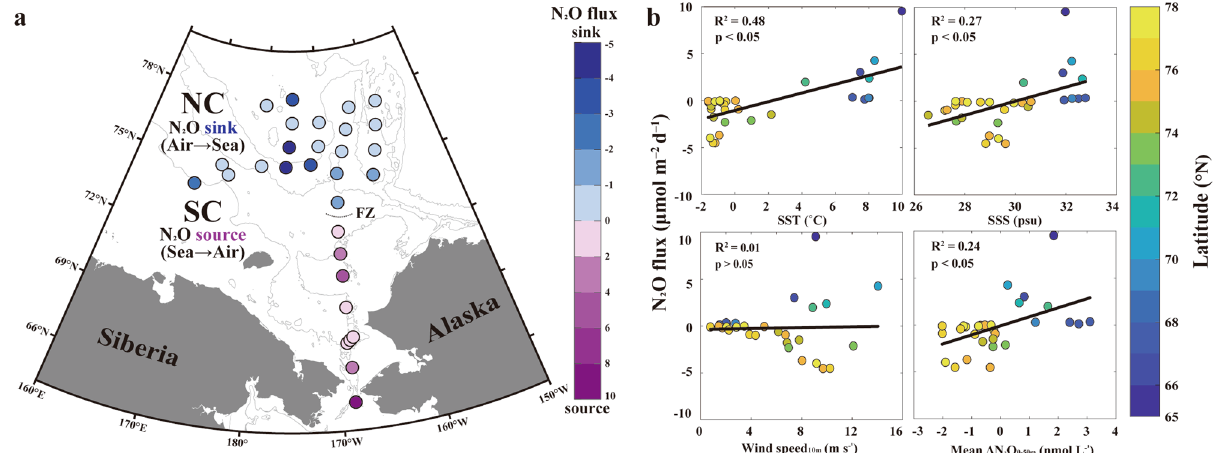
Figure 3. ( a ) Spatial distribution of mean WAO surface N 2 O fluxes across the air–sea interface during the summer of 2017 (blue to purple gradient color bar; sink (−), air → sea, and source (+), sea → air) and ( b ) correlations of N 2 O flux with SST, SSS, wind speed at 10 m (U 10 ), and mean ∆N 2 O 0–50 m (averaged between surface and 50 m), including statistical information (R 2 and p values). The color bar represents the latitude. Note that this figure was generated using MATLAB program (ver. R2019b and www. mathw orks. (SST), sea surface salinity (SSS), wind speed at 10 m (U 10 ), and mean ∆N 2 O 0–50 m (averaged between surface and 50 m) (Fig. 3b). The results showed that the relationships between the N 2 O flux and the SST (R 2 = 0.48, p < 0.05),